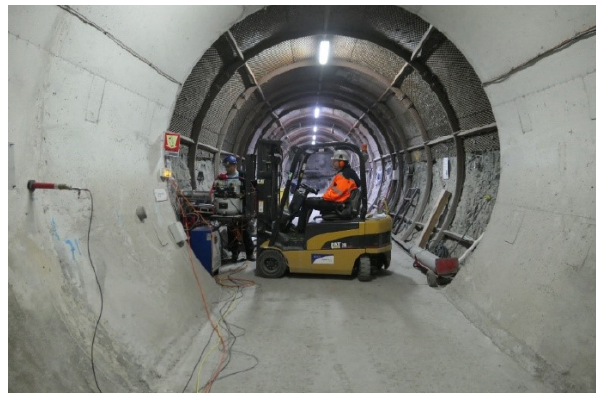
Figure 4. View into the gallery east-03 from the main tunnel show- ing the impact seismic source mounted at a fork lifter. In the fore- ground the tail end of a seismic receiver is located at the left tunnel